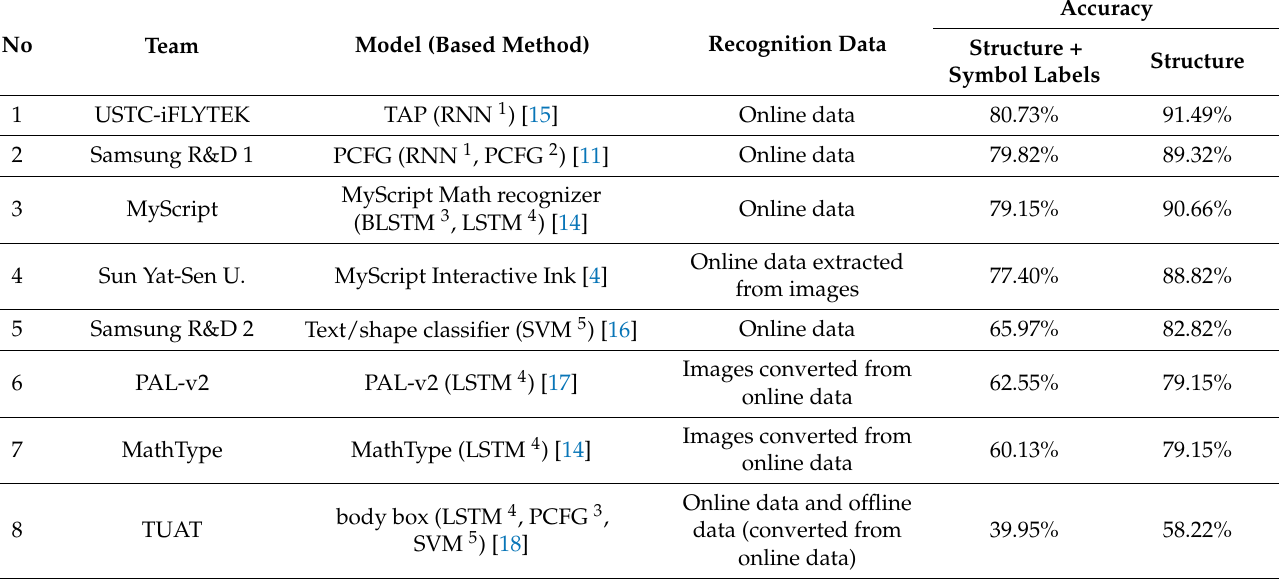
Table 1. Online handwritten mathematical expressions recognition